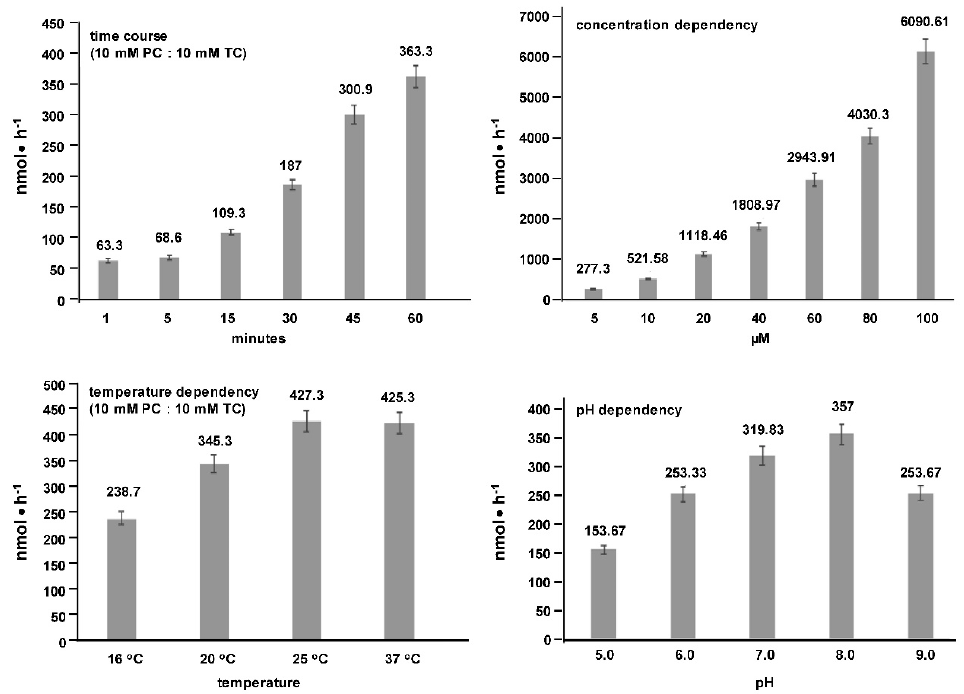
Figure 4. Transport characteristics of phosphatidylcholine (PC) to the apical side of polarized Mz-ChA-1 cells. Apical transport of PC was evaluated after exposure to the basal side. Transport was linear in regard to time and concentration (1 h incubation) with a temperature optimum between 25–37 ◦ C and a pH optimum in the range of pH 7.0 to pH 8.0. Means ± SD of n = 6. Transport was specific for the choline containing phospholipids PC, lysophosphatidylcholine (LPC) and sphingomyelin (SM) but not for other phospholipids (Figure 5).